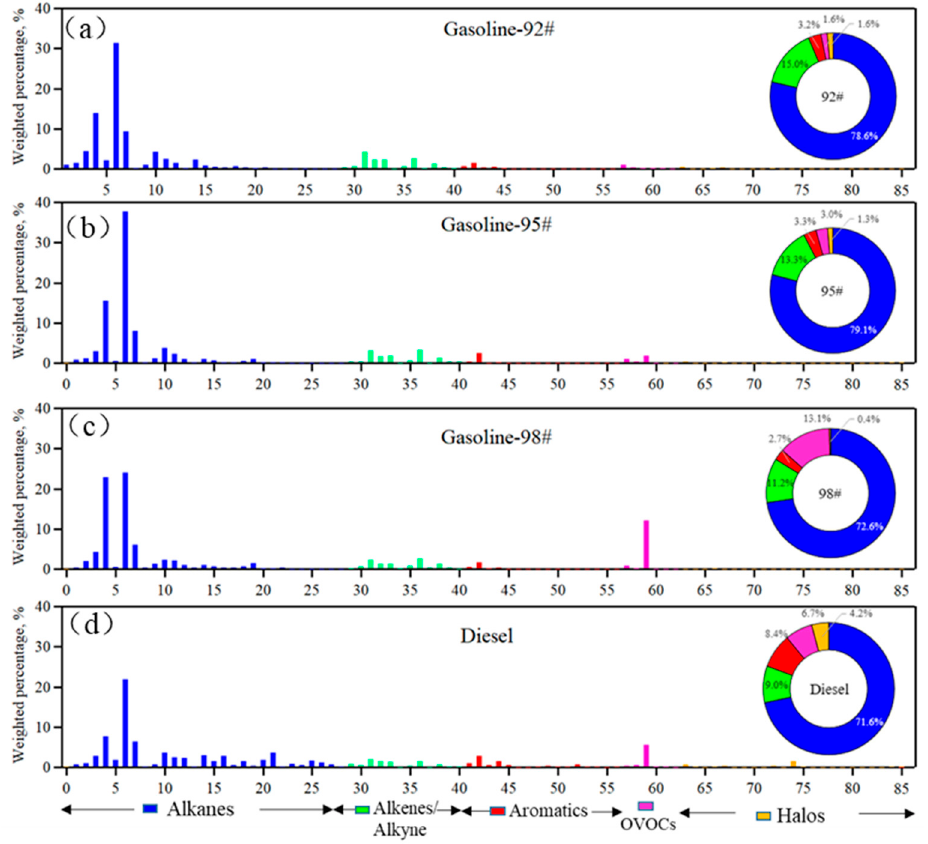
Figure 11. VOC source profile for gasoline and diesel; ( a ) gasoline-92#; ( b ) gasoline-95#; ( c ) gasoline-98#; ( d ) diesel-0#.